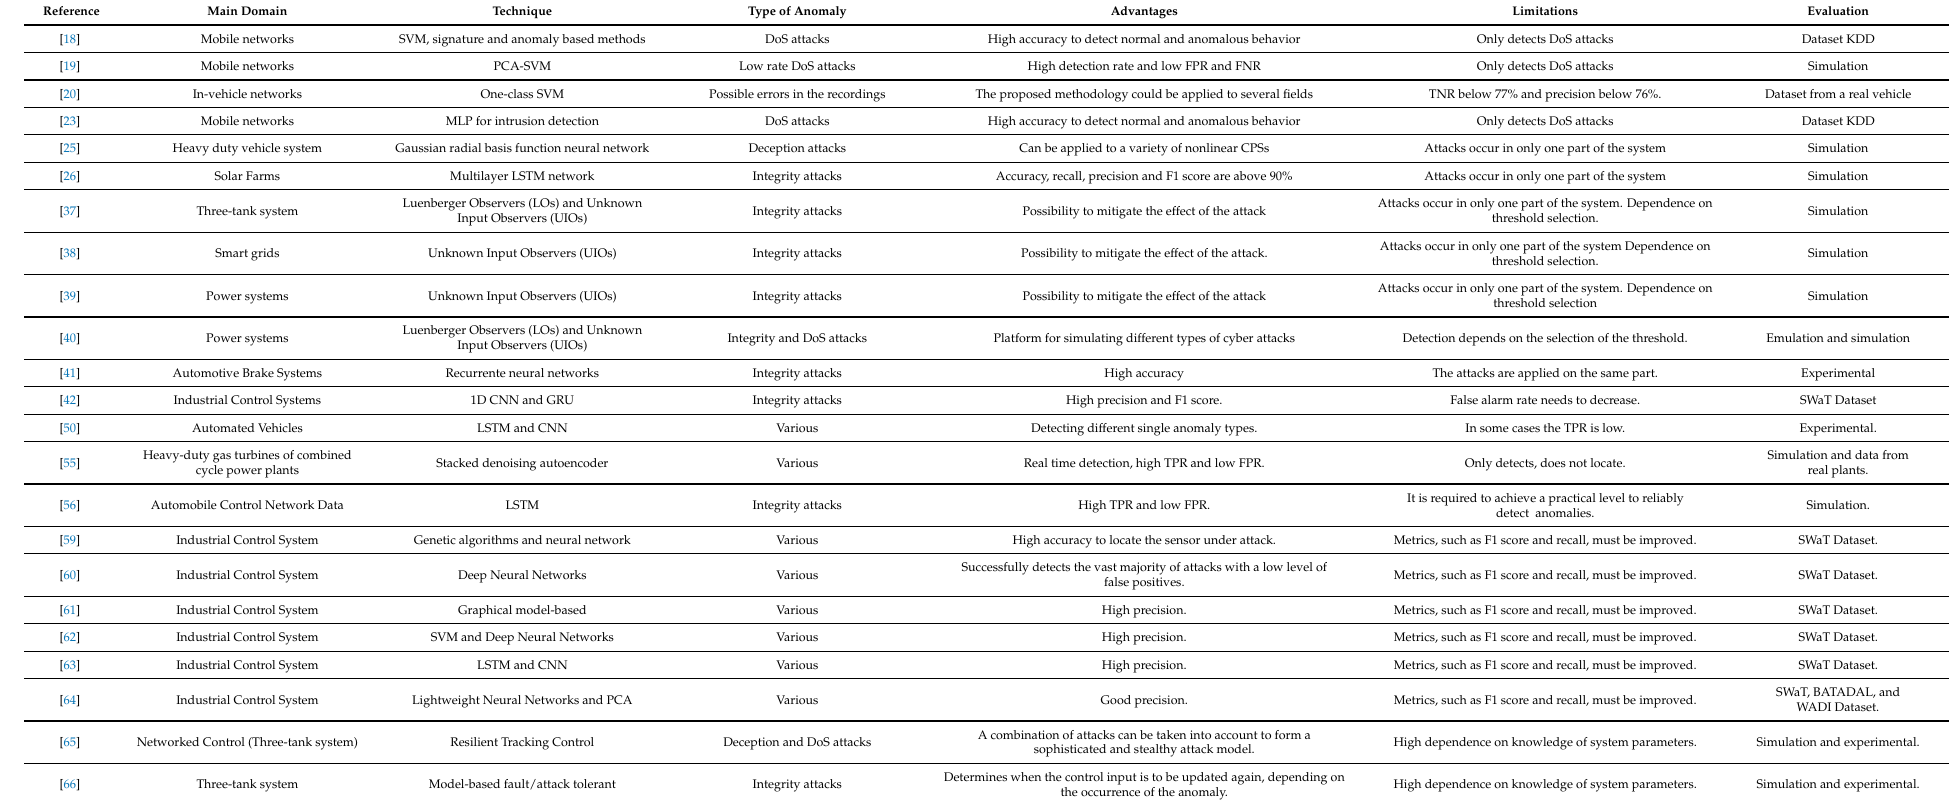
Table 1. Summary of related